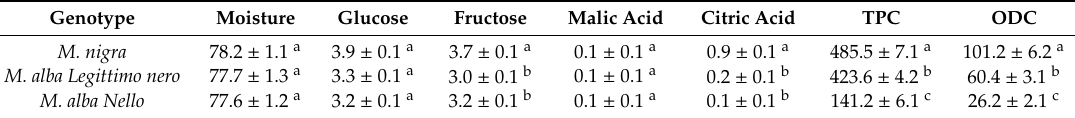
Table 1. Amounts of moisture (%), glucose, fructose, malic and citric acid (expressed as g / 100 g FW), compounds (ODC) (mg of chlorogenic acid / 100 g FW) in di ff erent mulberry fruit varieties. Values represent the results of three determinations ± SD; means with di ff erent letters in the same column are significantly di ff erent from each other ( p < 0.05) according to the multicomponent Duncan’s test. Genotype Moisture Glucose Fructose Malic